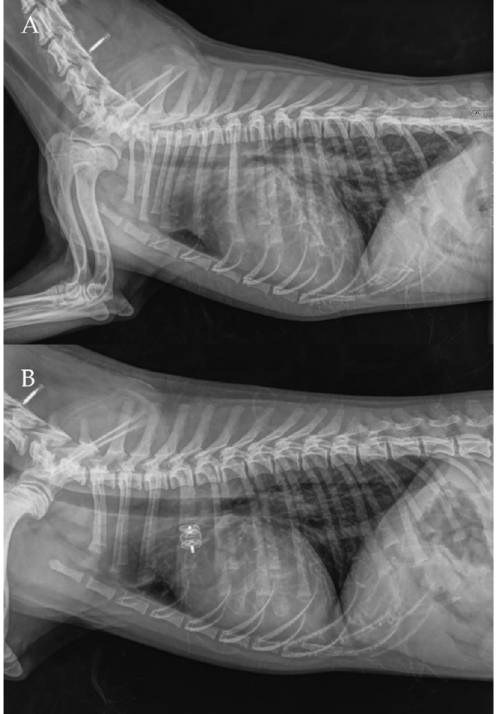
Figure 9. Pre-procedure ( A , B ) and post-procedure ( C , D ) left lateral and dorso-ventral thoracic radiographs of Case 2. L: left; R: right.